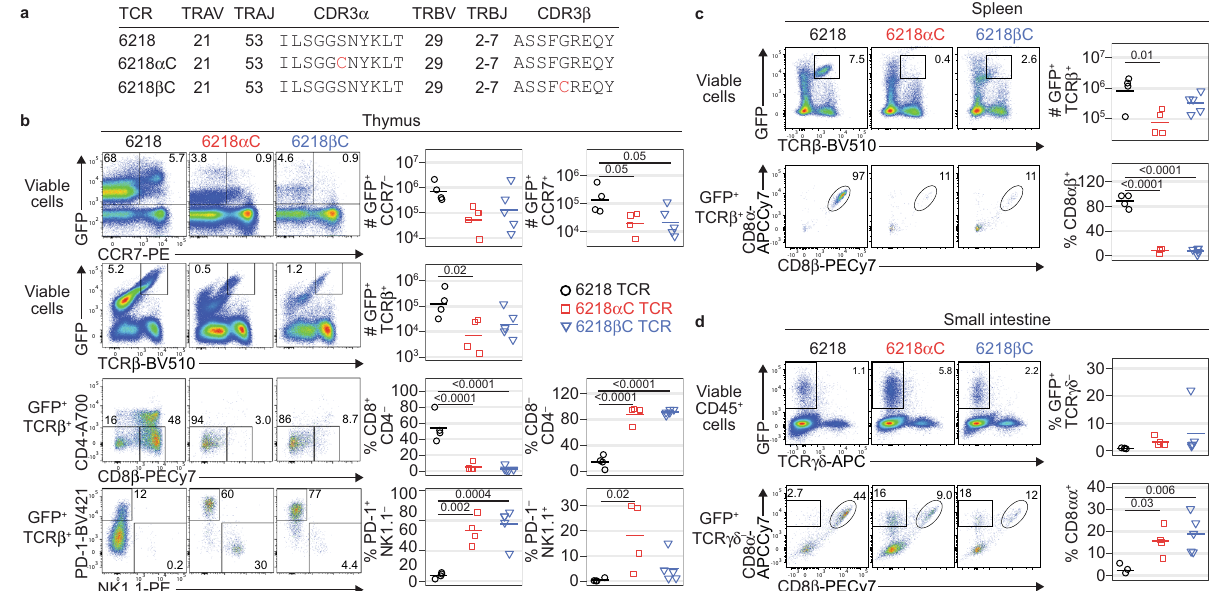
Fig.1|TcellfatealteredbyacysteineinCDR3.a Detailsofthe6218,6218 α Cand 6218 β C TCRs. b Incorporation of Cys at the CDR3 apex alters T cell fate. BM cells pooled from Rag1 – / – mice (7 female and 6 male; aged 37-134 d) were transduced with retroviruses encoding GFP and the 6218, 6218 α C or 6218 β C TCR and then mixed1:1 with T cell-depleted BM cellsfrom a male B6mouse beforeinjectioninto irradiated Rag1 – / – mice (3 female and 1 male for 6218; 4 female for 6218 α C and 5 male for 6218 β C). The resulting TCR-retrogenic mice were analysed 5 weeks after BM transfer at 90-171 days of age. Plots show the GFP/CCR7 (row 1) and GFP/TCR β (row 2) FACS phenotypes of live thymocytes, with a gate for GFP + TCR β + thymo- cytesthatwereanalysedforCD4/CD8 β (row3)andPD-1/NK1.1(row4). c GFP/TCR β